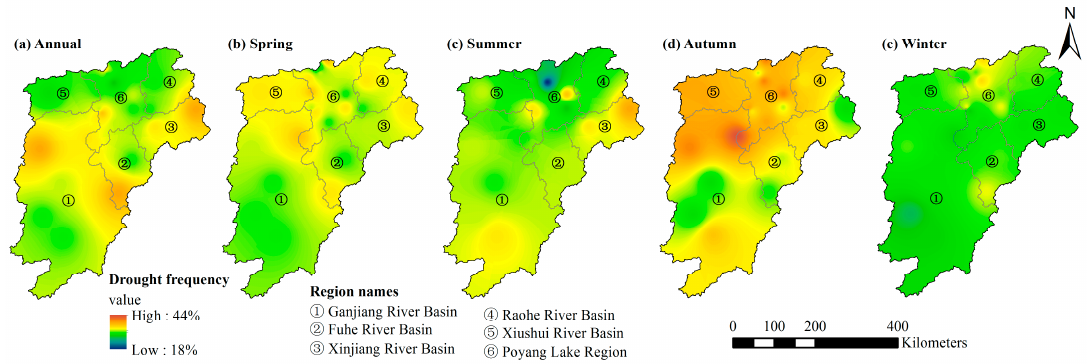
Figure 10. Spatial distribution of meteorological drought frequency. ( a ) Annual; ( b ) Spring; ( c ) Summer; ( d ) Autumn; ( e ) Winter.